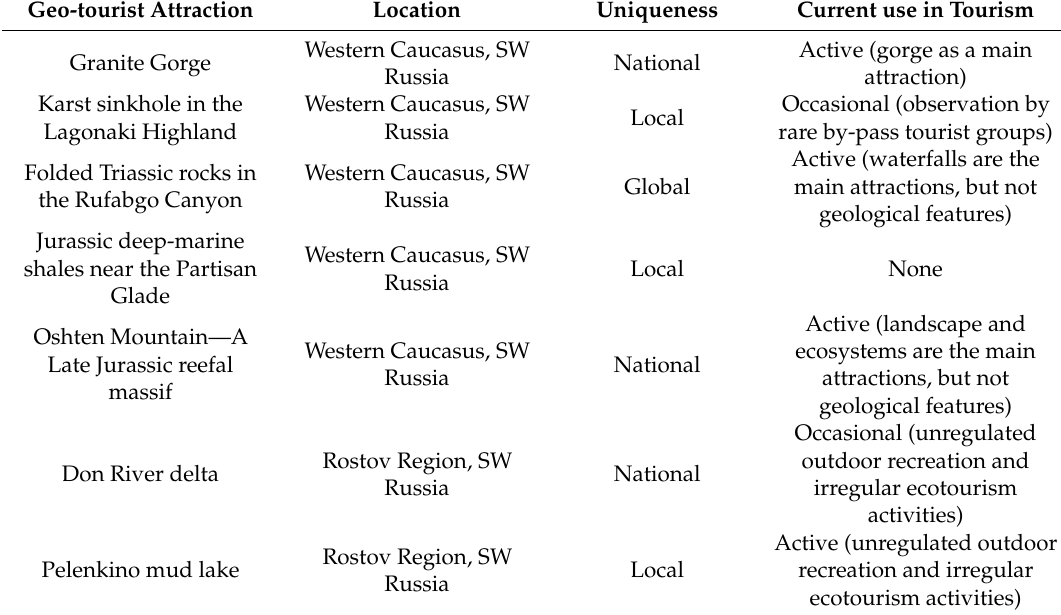
Table 2. Basic characteristics of the geo-tourist attractions considered as case